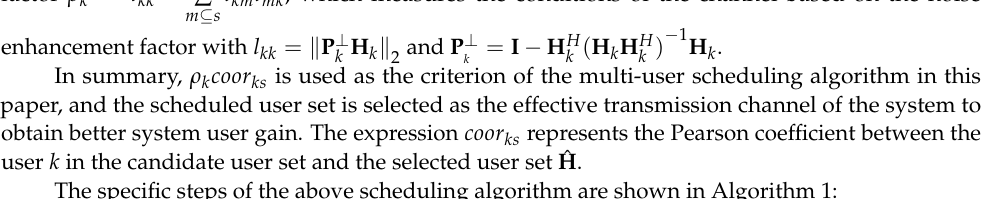
Algorithm 1 Multi-User Scheduling Based on BD Precoding for UM-MIMO